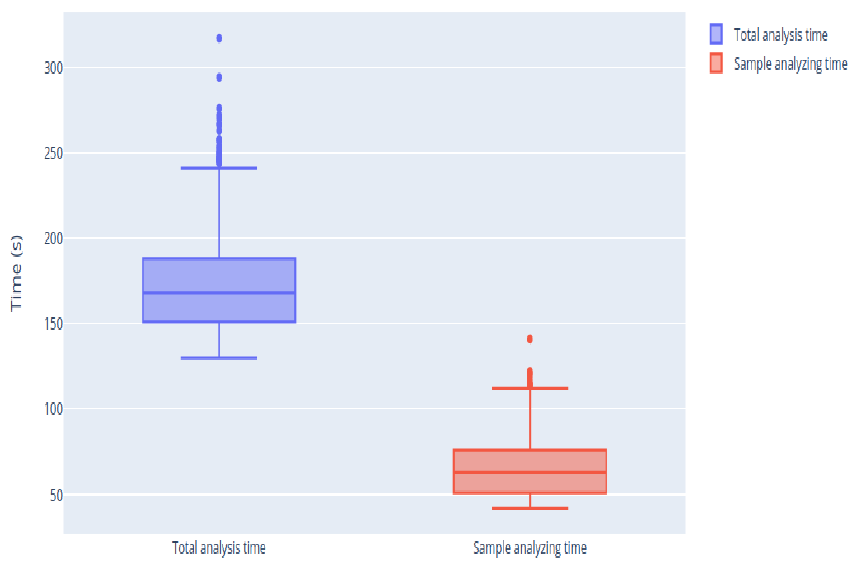
Figure 11. Box-plots of the duration of the different phases present in a sample